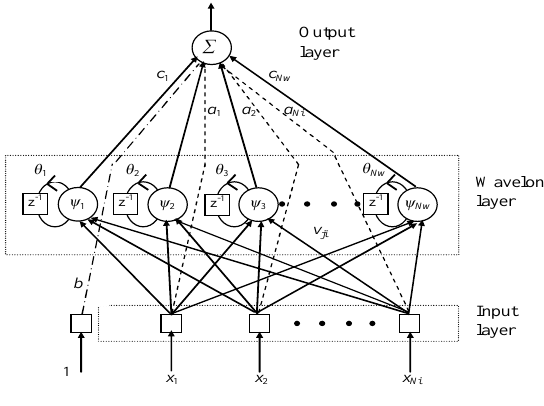
Fig. 2. Structure of the SRWNN